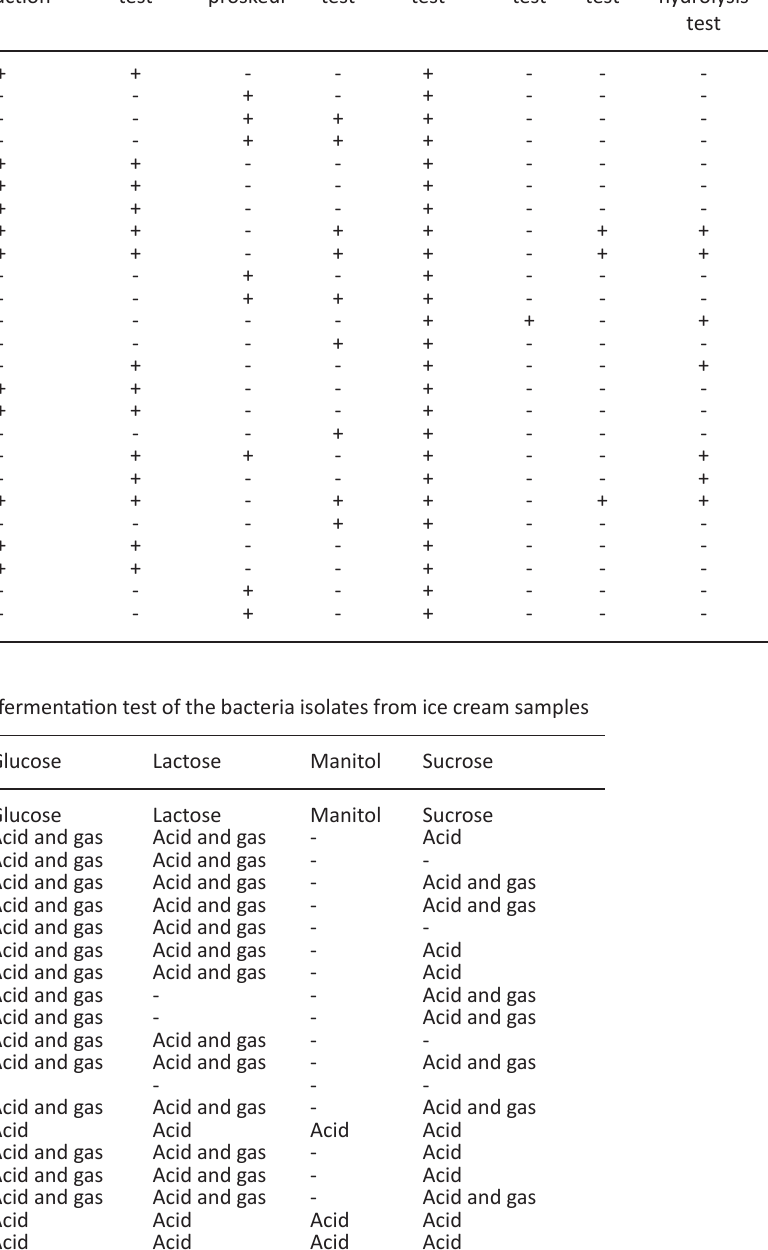
Table 3. Biochemical test of the bacterial isolates from ice cream samples Isolate Indole Methyl red Vogues Urease Catalase Oxidase H2S Gelatin Citrate No production test proskeur test MKII 1 - - + + + + - - - -